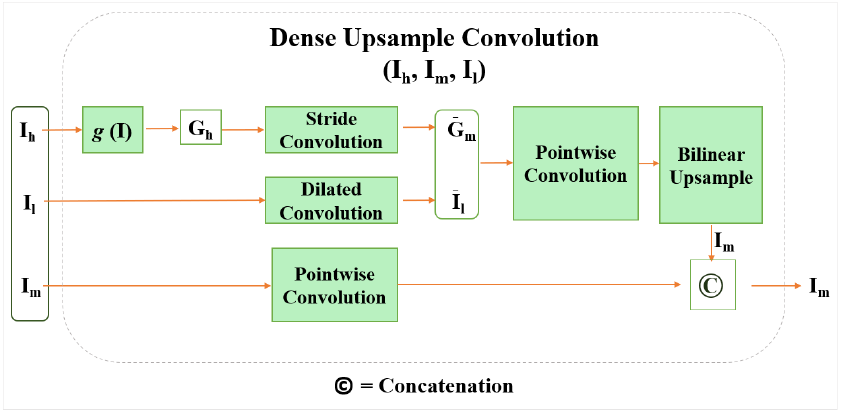
Figure 3. Computational graph of the proposed dense upsampling convolution (DUC) method.